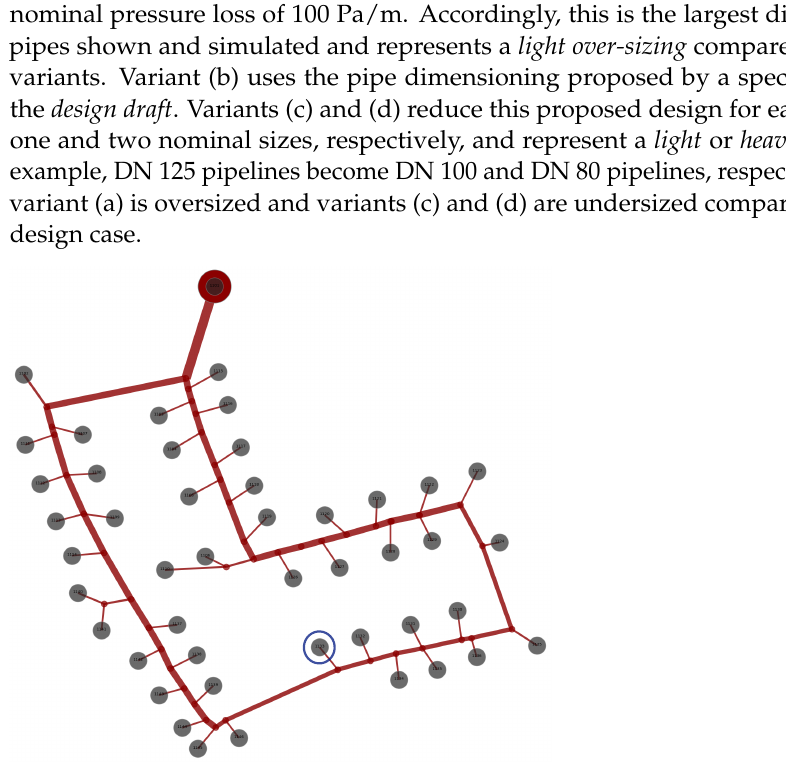
Figure 9. Network layout of the area in the town of